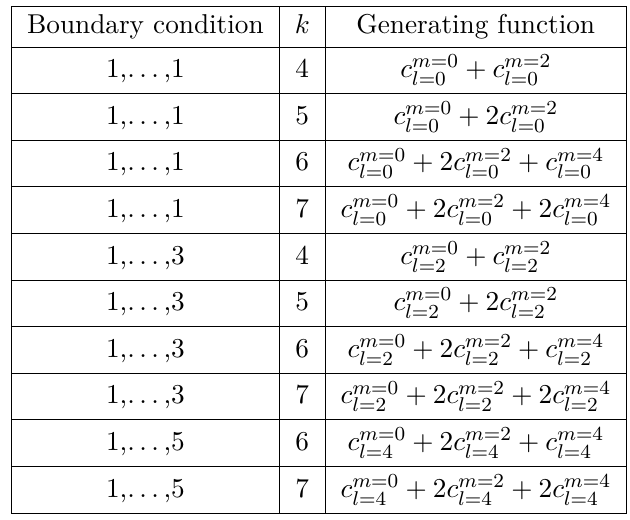
Table 1 . The continuum limit of the RSOS